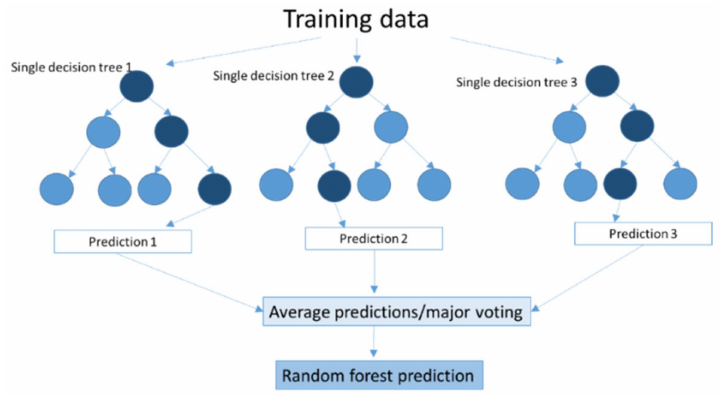
Figure 2. Scheme of Random